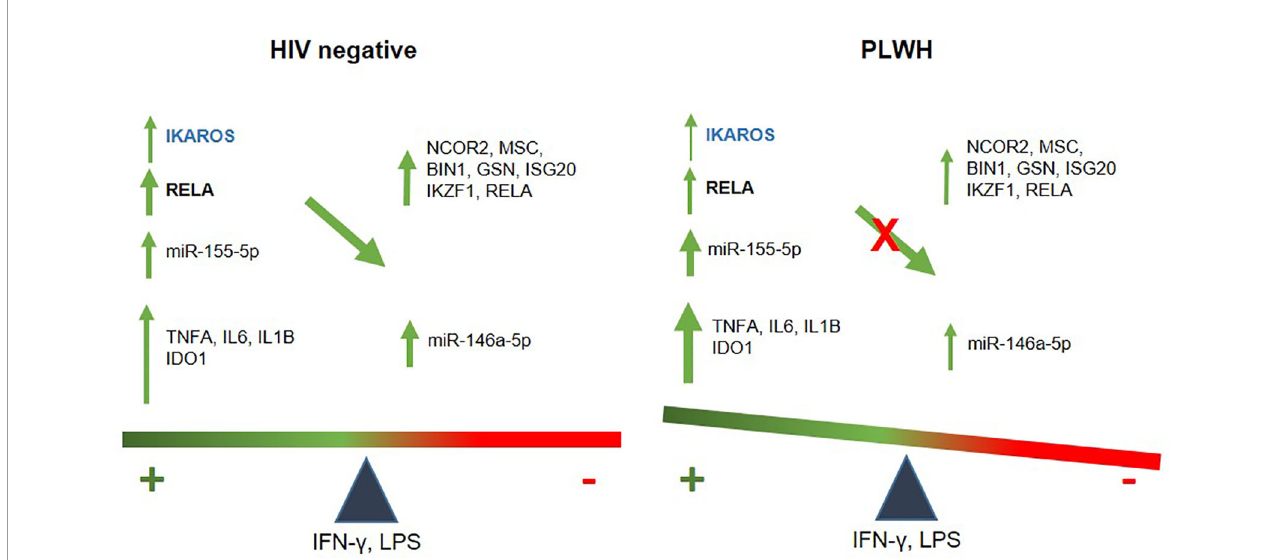
FIGURE 7 | Schematic illustration of an imbalanced immune response in PLWH. In healthy controls, temporally-regulated positive (miR-155-5p, IDO1, IL6, TNFA and IL1B) and negative feedbacks (146a-5p, NCOR2, GSN, MSC, IKZF1, BIN1, ISG20, and RELA) will lead to a balanced immune response, with IKZF1 and RELA playing a central role in the transcription of negative regulators. Instead, attenuated IKAROS/RELA axis in PLWH-MDMs results in positive signals dominating over negative feedback. This imbalanced immune response may contribute to chronic in fl ammation and increase the risk of